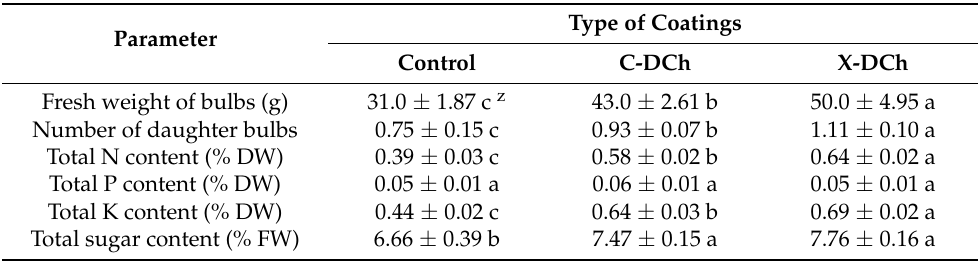
Table 2. Fresh weight of bulbs, number of daughter bulbs, total N, P, K, and total sugar content in bulb of pineapple lily treated with carrageenan-depolymerized chitosan (C-DCh) or xanthan- depolymerized chitosan